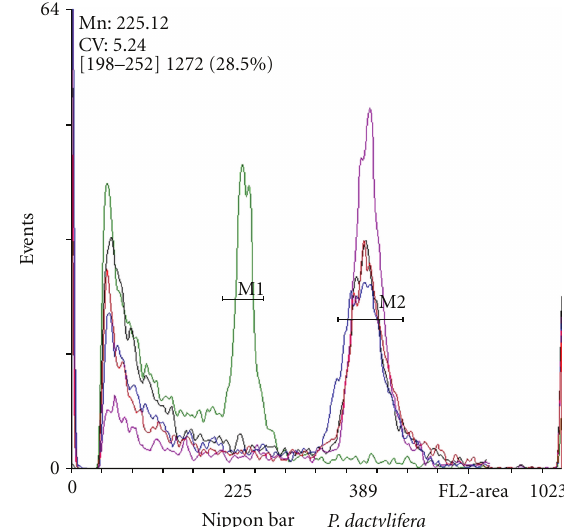
Figure 4: Flow cytometry analysis of nuclear DNA from leaves of rice (Nippon bar) seedlings (green), date palm cv. Ahmar seedlings (violet), and date palm cv. Ahmar somatic embryo-derived plantlets (red, black, and